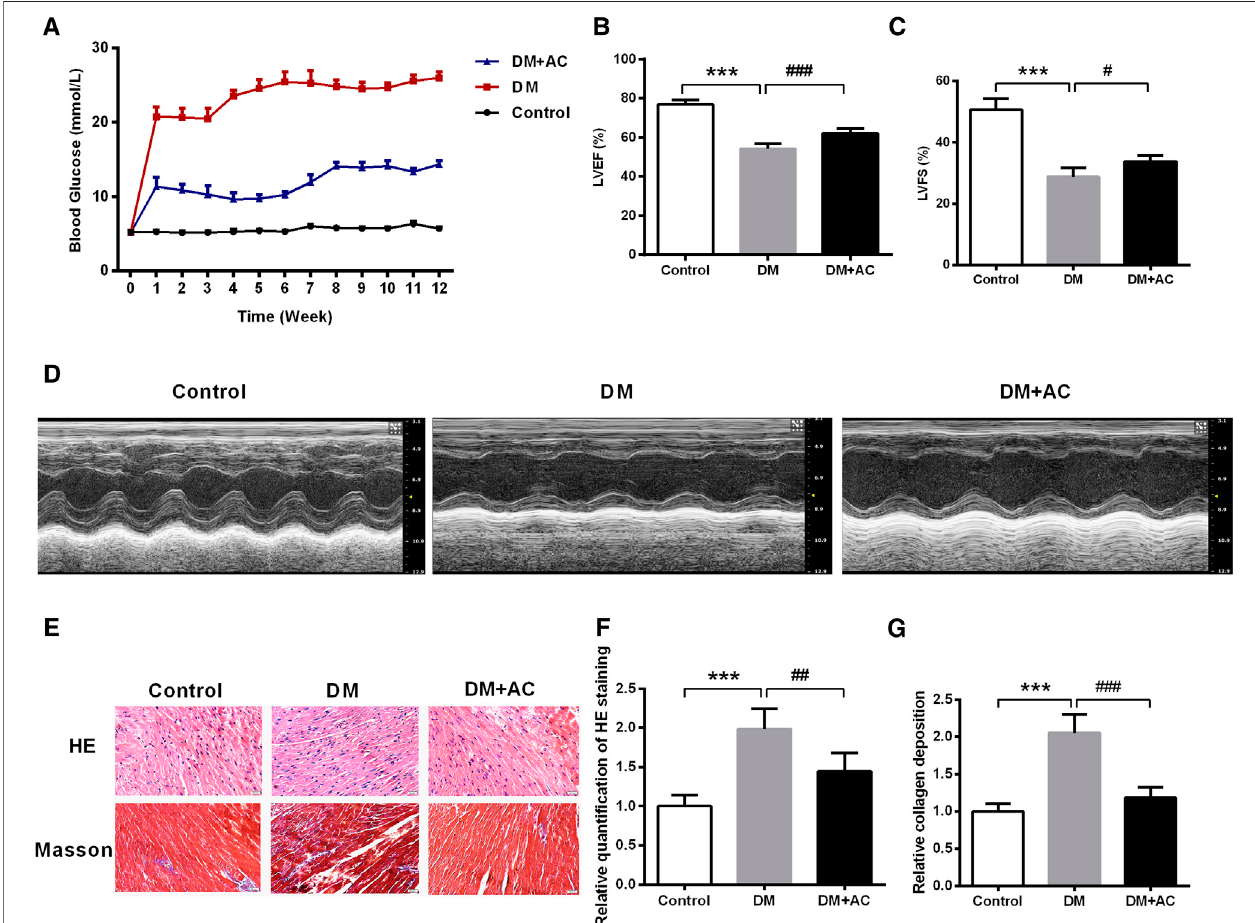
FIGURE 1 | Anthocyanin reduces blood glucose and improves cardiac function in diabetic mice. (A) Blood glucose from 0 to 12 weeks. (B) Left ventricle ejection fraction (LVEF) and (C) Left ventricular fractional shortening (LVFS) are shown. (D) M-mode echocardiograms of left ventricle. (E) Hematoxylin and eosin (HE) and Masson ’ s trichrome staining. (F) Relative quanti fi cation of HE staining. (G) Relative collagen deposition. Scale bar, 50 μ m. *** p < 0.001 vs. Control, ## p < 0.01 vs. diabetes mellitus (DM); ### p < 0.001 vs. DM; n (cid:1) 5.